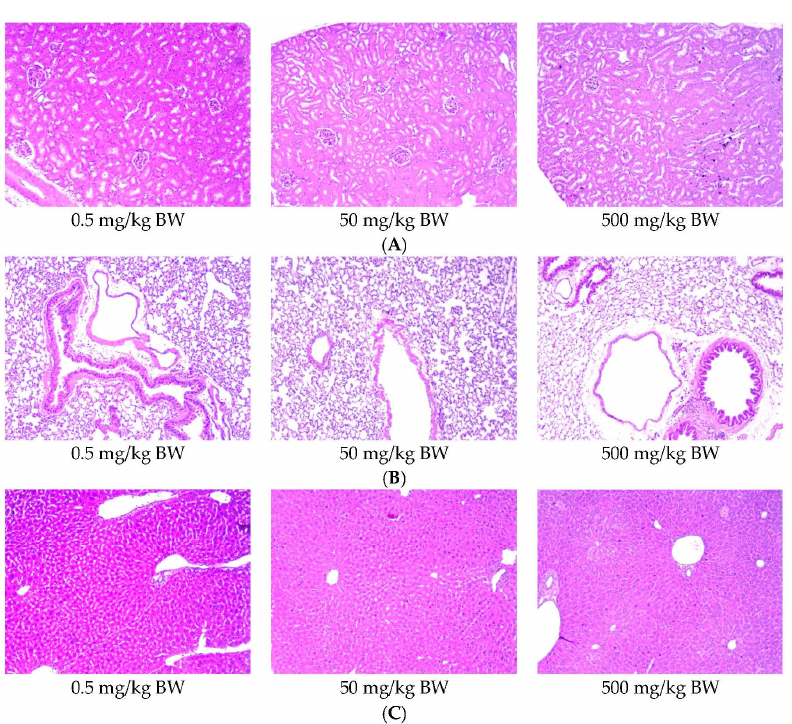
Figure 10. Histology of kidney ( A ), lung ( B ), and liver ( C ) of mice after intranasal administration of IgY anti SARS-CoV-2 at different doses (magnification: 100x).